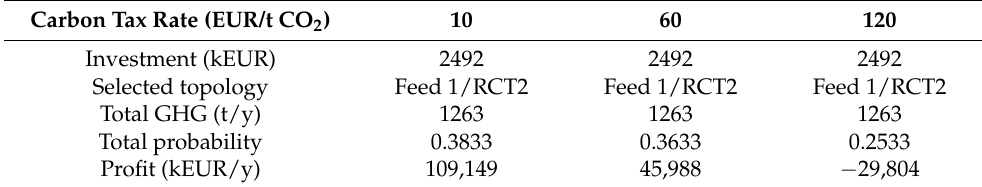
Table 7. Results of deterministic synthesis of heat-integrated